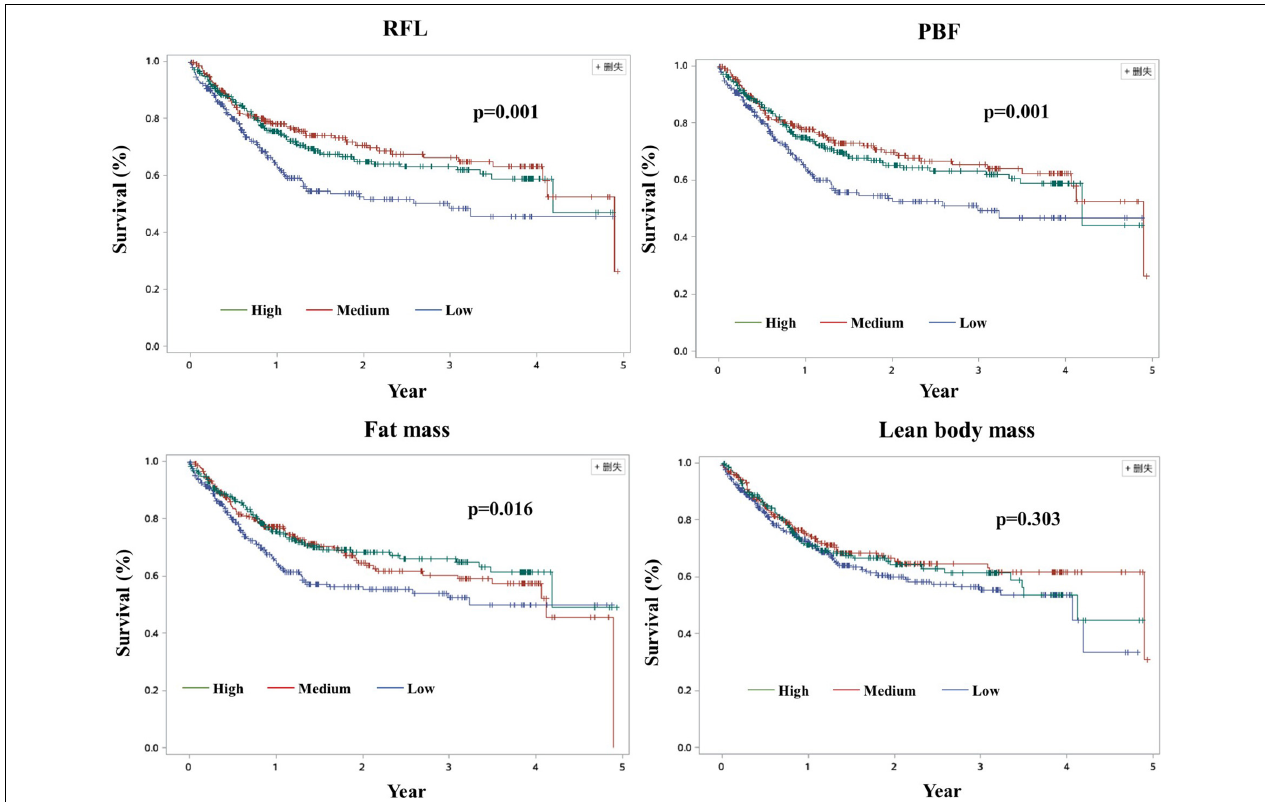
FIGURE 2 | Kaplan–Meier curves among men cancer patients aged ≥ 60 years. RFL: Fat mass to lean body mass ratio; PBF, Percentage of body